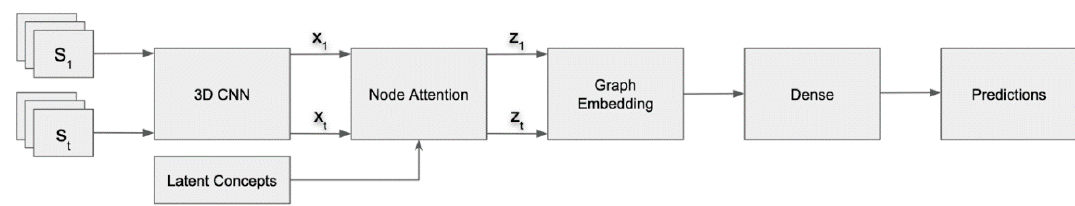
Figure 1 . VideoGraph block diagram [17]. A 3D CNN is used to extract features, which are then used to build nodes and